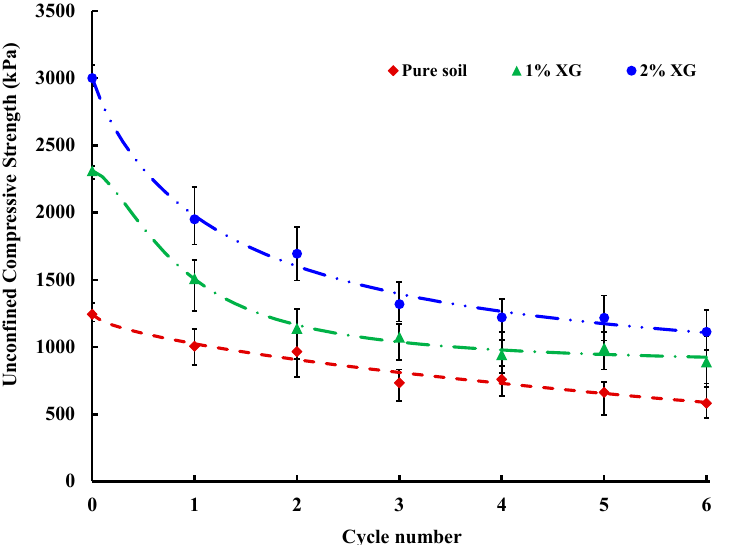
Figure 9. Variations in unconfined compressive strength of the XG-treated soil with wetting and drying cycles.